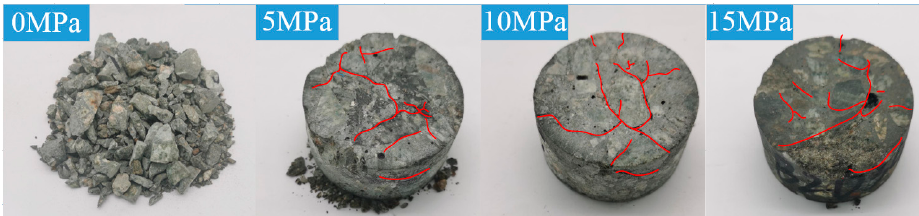
Figure 8. The crushing morphology of specimens under different confining pressures. (impact velocity: 11.3 m/s).